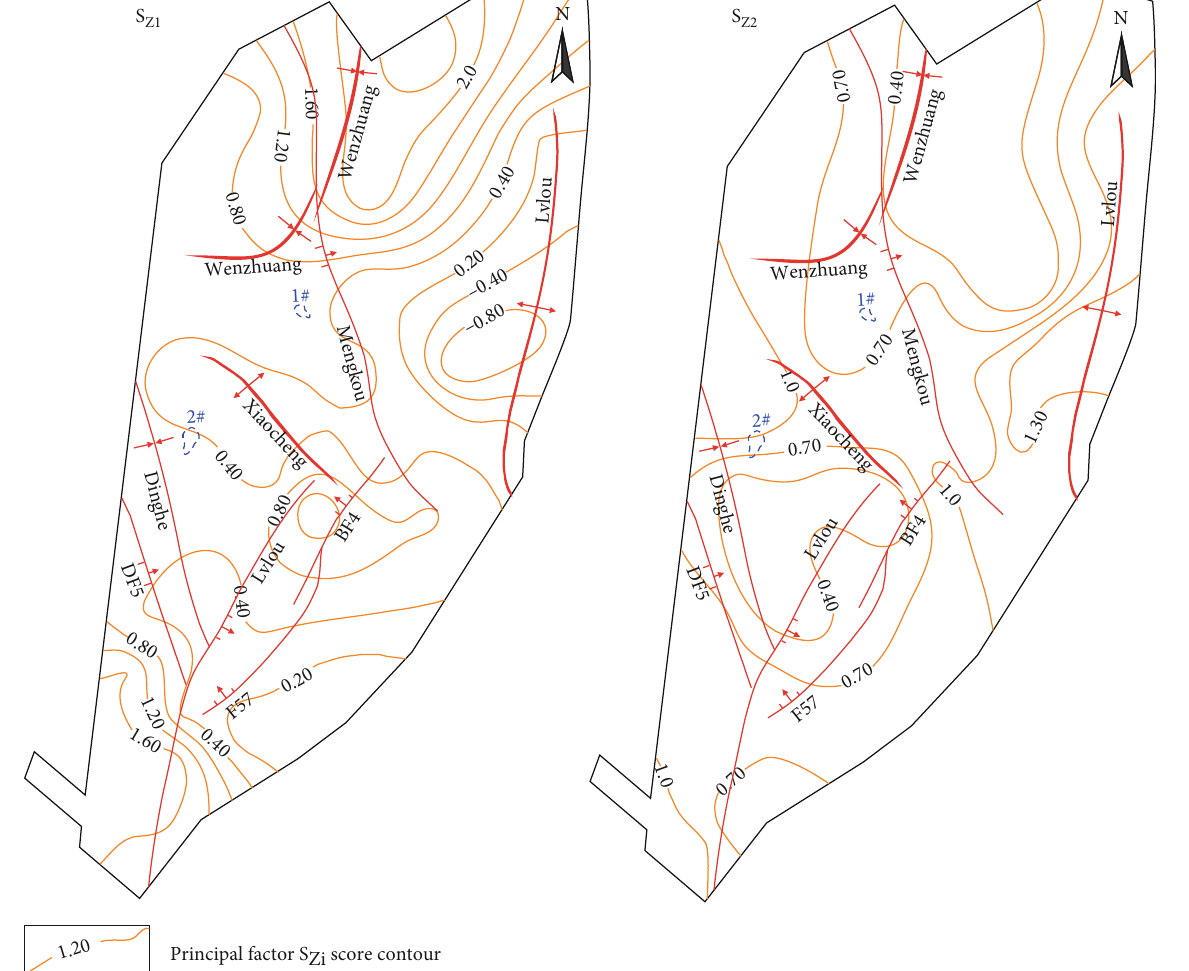
S Z 1 , Z 2 for Permian